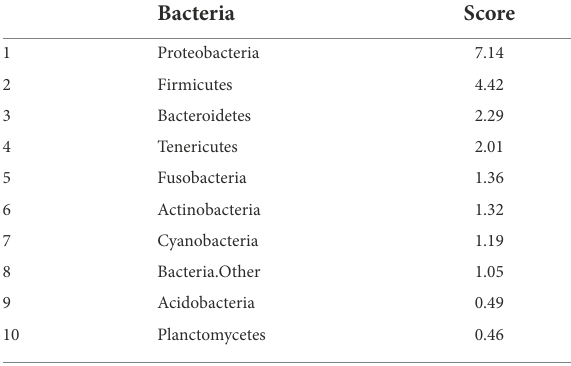
TABLE 3 NGS importance ranking for separating intrasalmoniformes computed using the i-means method.